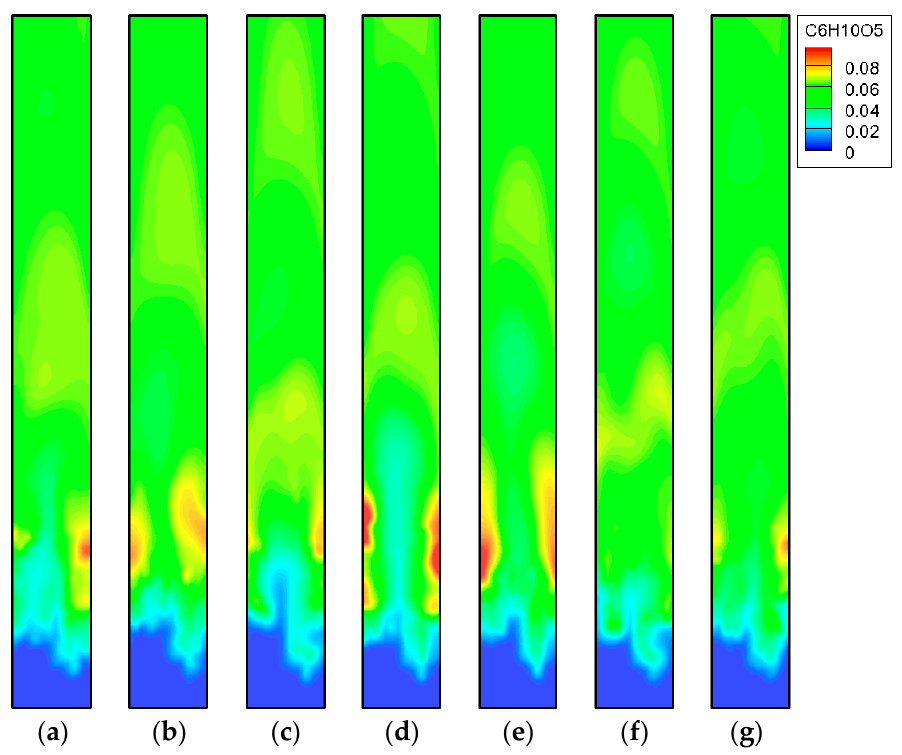
Figure 6. CO mass fractions. ( a ) 9 s, ( b ) 9.1 s, ( c ) 9.2 s, ( d ) 9.3 s, ( e ) 9.4 s, ( f ) 9.5 s, and ( g ) 9.6 s. Energies 2020 , 13 , x FOR PEER REVIEW 11 of 20